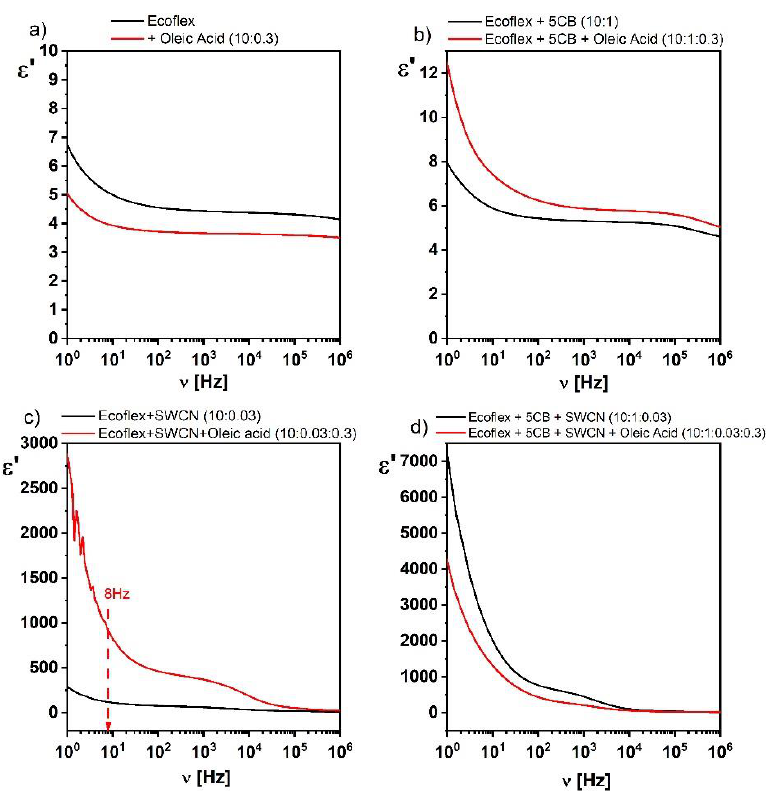
Figure 3. Influence of the oleic acid on the dielectric response of the pure Ecoflex ® ( a ), Ecoflex ® :5CB ( b ), Ecoflex ® :SWCN ( c ), and Ecoflex ® :5CB:SWCN ( d ) layers.